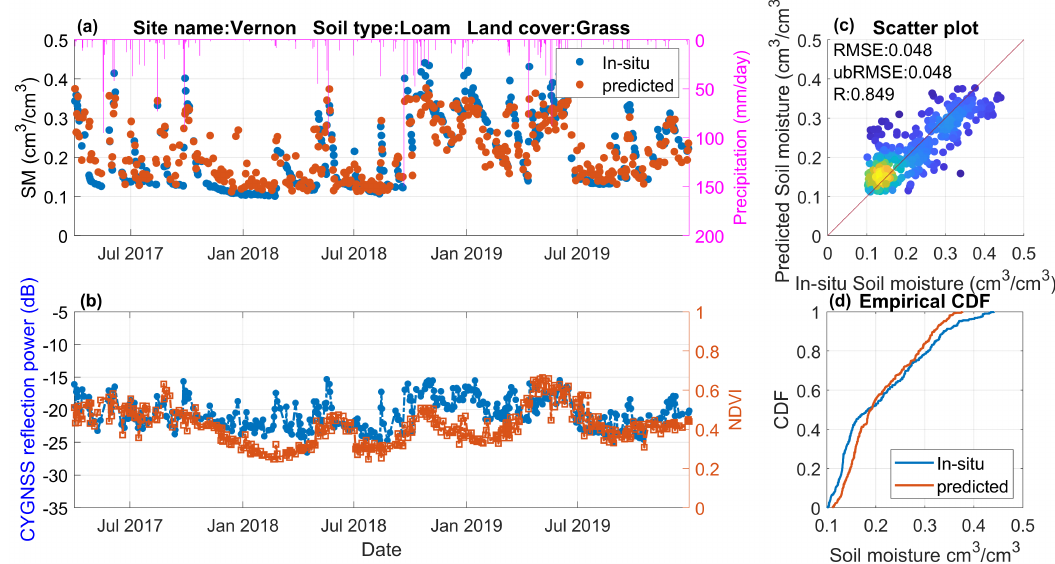
Figure 12. Comparison of ( a ) the in-situ observed and predicted SM time series and ( b ) CYGNSS reflectivity and normalized difference vegetation index (NDVI) time series for site Vermon. ( c ) The scatter plot and ( d ) cumulative density function (CDF) between predictions and measurements.